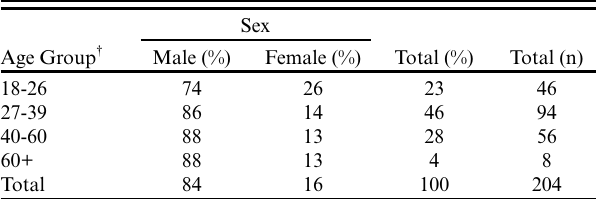
Table 2 . Prescribed Fire Training Exchange participant